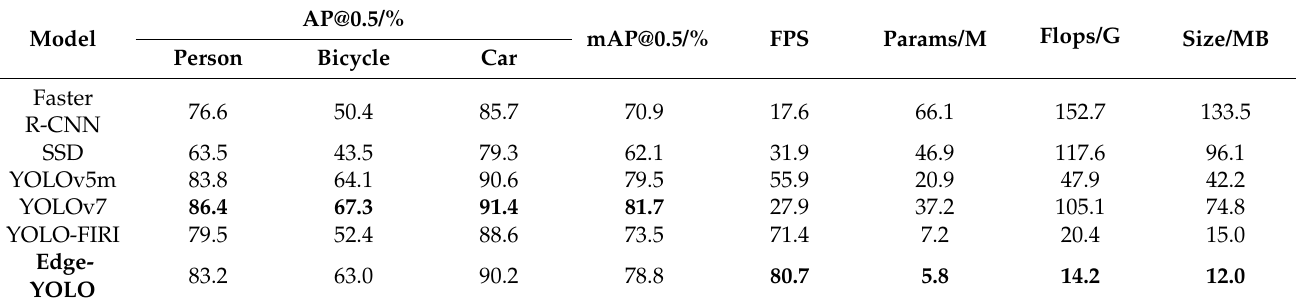
Table 3. Comparison of mainstream target detection